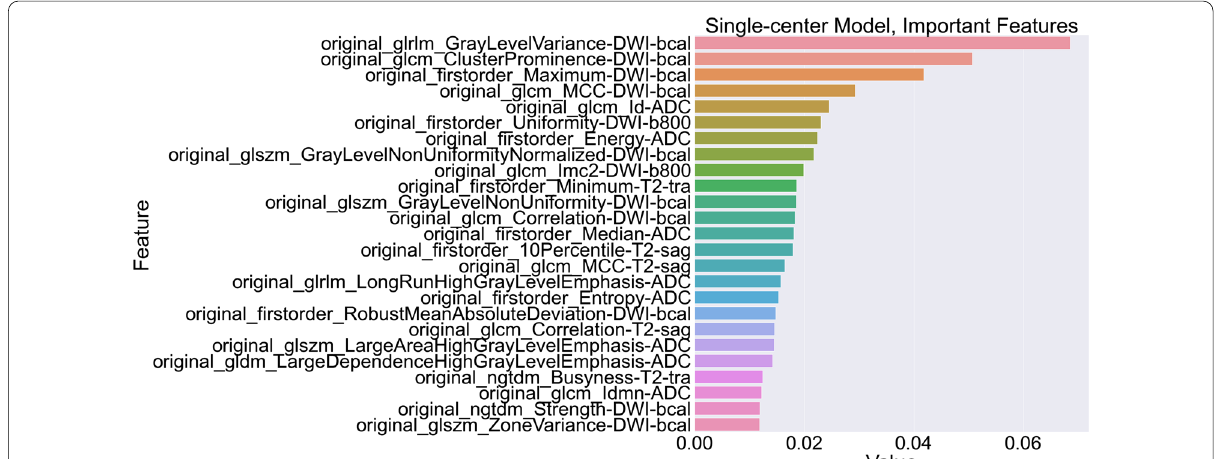
Fig. 4 “Gain” values for the top 25 most important features of the single-center model trained on a dataset containing 171 single-center PCa lesions. Higher gain means a higher positive effect on the end performance